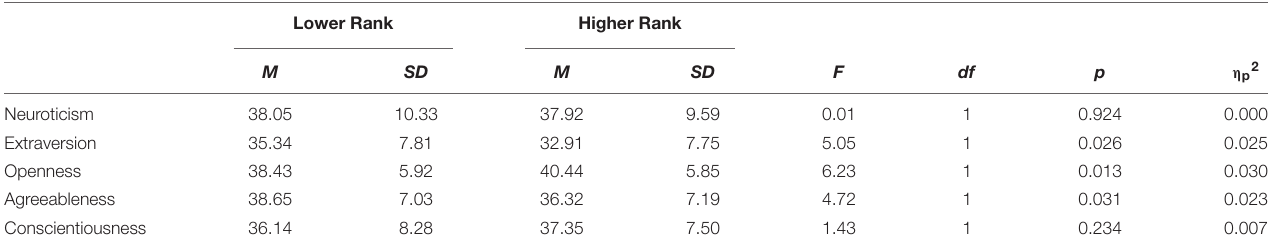
TABLE 1 | MANOVA results for comparison of lower and higher ranked players. Lower